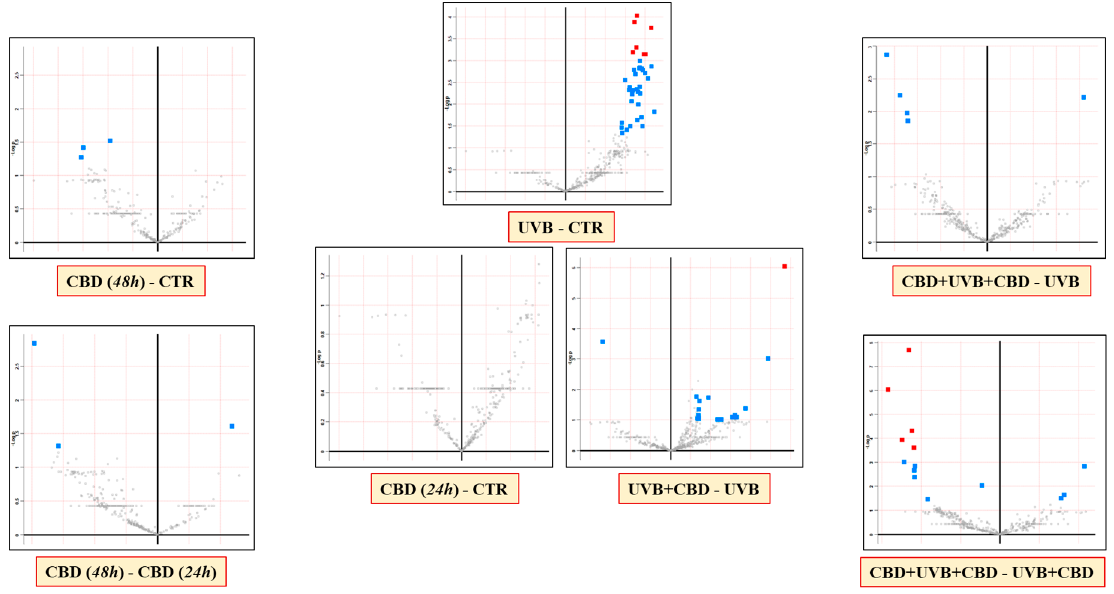
Figure 3. Volcano plots comparing the effects of cannabidiol (CBD) on membrane fractions proteins of keratinocytes from the following groups: CTR—control cells cultured with standard medium; CBD(48 h)—cells cultured in medium containing CBD (4 μ M) for 48 h; CBD(24 h)—cells cultured in medium containing CBD (4 μ M) for 24 h; UVB—cells irradiated with UVB (312 nm) at 60 mJ/cm 2 ; CBD + UVB + CBD—cells cultured in medium containing CBD (4 μ M) for 24 h before and after UVB irradiation; and UVB + CBD—cells cultured in medium containing CBD (4 μ M) for 24 h after UVB irradiation. [significant features (in blue) had p < 0.05; significant features (in red) had FDR-adjusted p -value < 0.05].